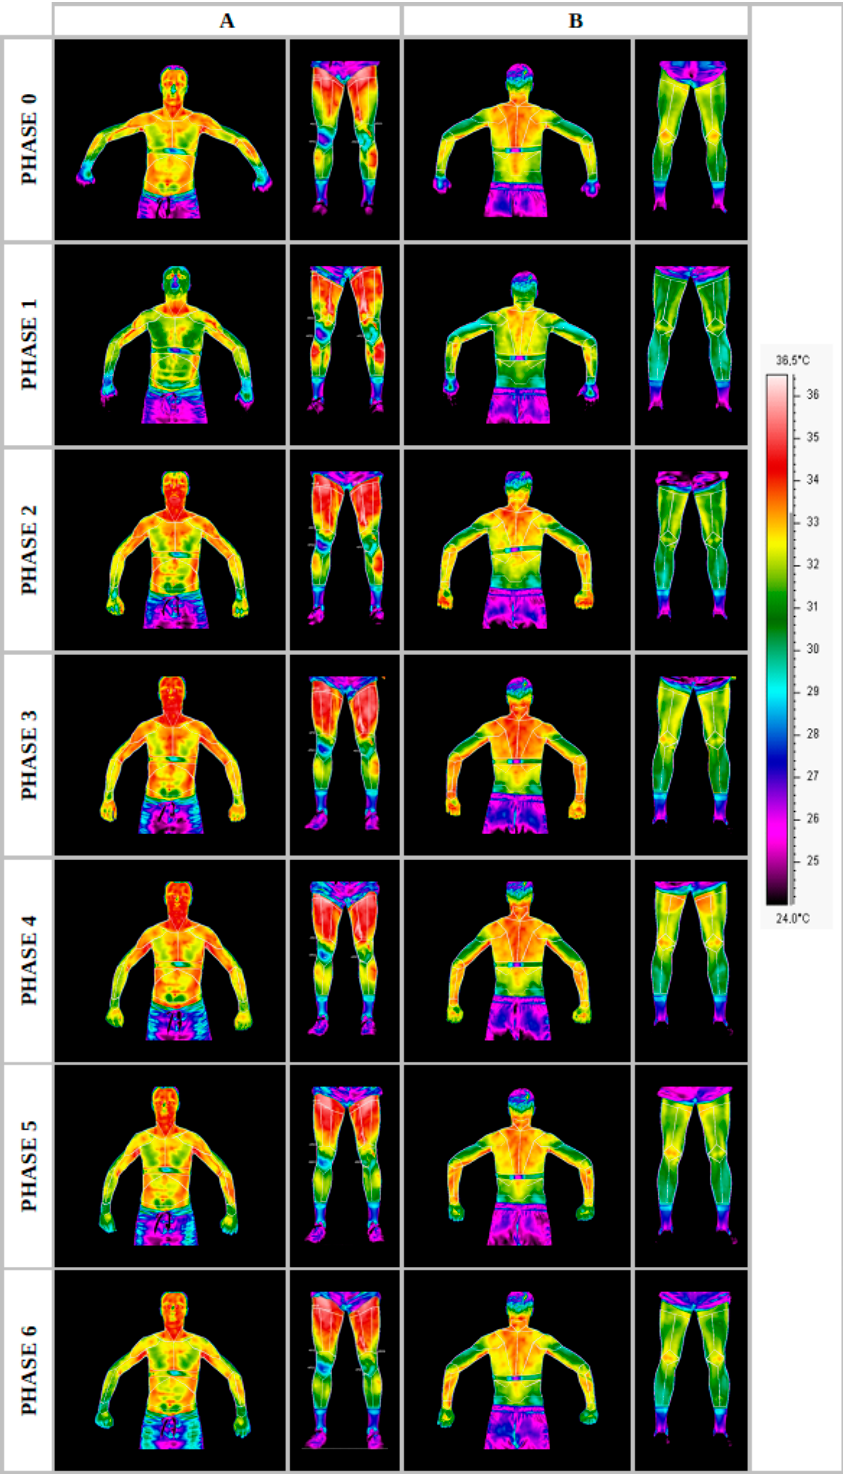
Figure 2. Thermograms representing the temperature maps of the front ( A ) and rear ( B ) body surfaces of a professional group representative, recorded in each measurement phase. Source: own research carried out following the methodology described.